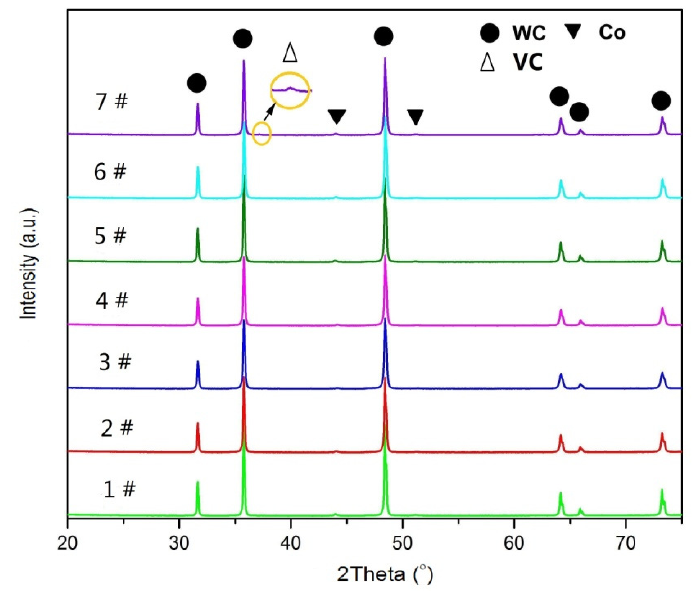
Figure 2. XRD patterns of WC–6Co–(Cr 2 C 3 /VC) cemented carbides sintered at 1450 ◦ C. 1#: WC–6Co; 2#: WC–6Co–0.25Cr 3 C 2 ; 3#: WC–6Co–0.6Cr 3 C 2 ; 4#: WC–6Co–1.0Cr 3 C 2 ; 5#: WC–6Co–0.25VC;